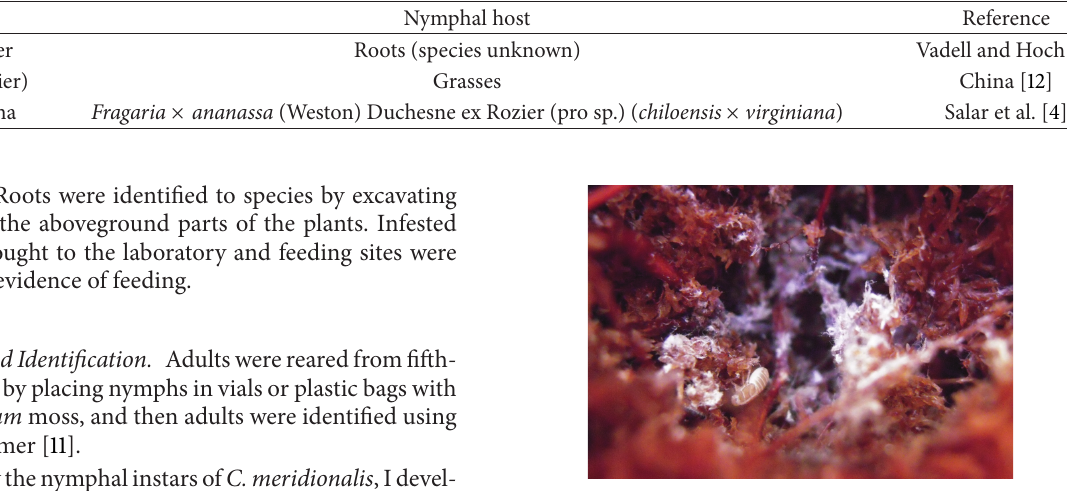
Figure 1: Fourth instar C. meridionalis nymph in situ , July 12, 2013. The disturbed nymph had moved from its feeding site on a root of Chamaedaphne calyculata